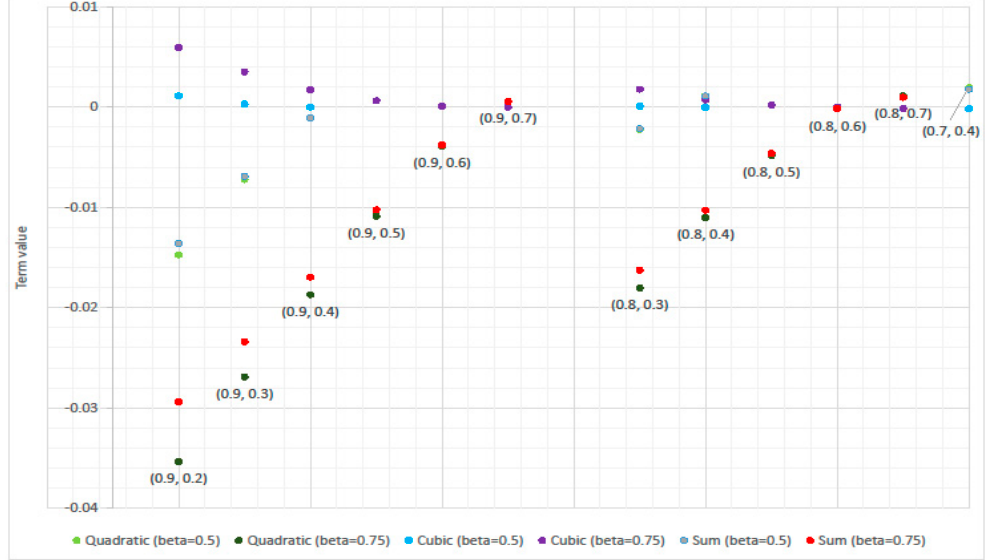
Figure 1. Quantified quadratic (second-order) and cubic (third-order) terms in the ‘1 / 3-rule’ extension, via Inequality (2) of Theorem 1. Non-negligible sums, quadratic plus cubic terms, were also quantified. Setting β = 0 and γ = 1 simplified the plot in two dimensions. Values in parentheses ( c 1 , c 3 ) , increments of 0.1 from left to right, where 0 < c 1 , c 3 < 1 such that c 1 > c 3 , or equivalently α > δ . Necessarily, c 1 + c 3 > 1 ensures a non-degenerate deterministic equilibrium relative frequency of cooperation. Selection intensity σ = 1. The vertical axis represents the calculated term values. In non-harmful contests, β < δ .